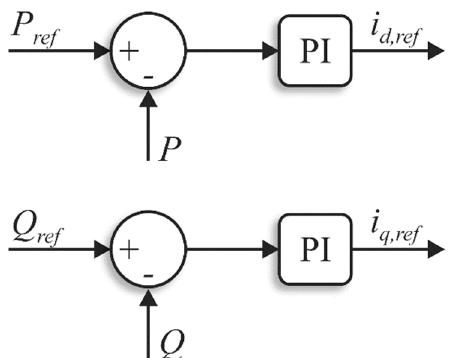
Figure 2. Current control block.